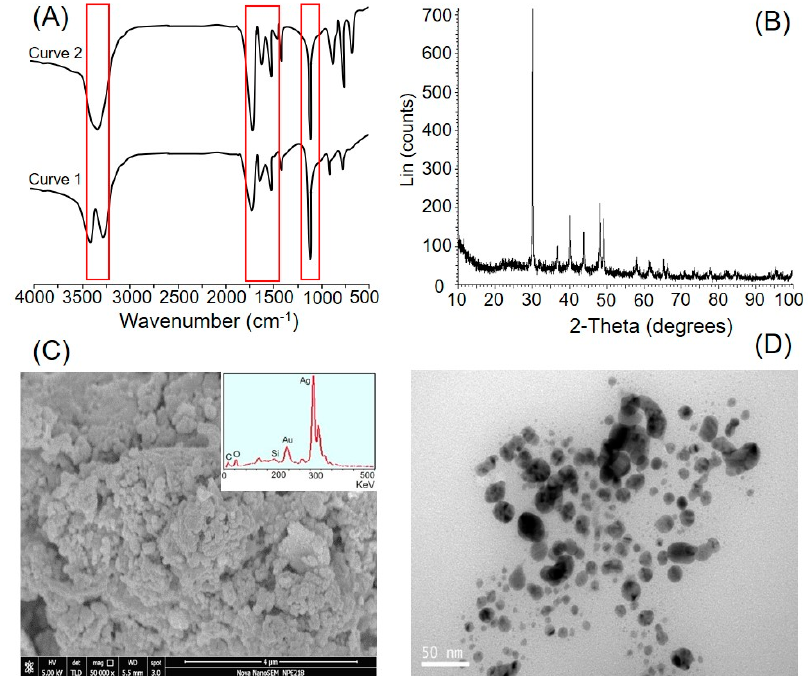
Figure 2. Characterization of Convolvulus arvensis AgNPs: ( A ) Fourier transform infrared spectroscopy (FT-IR) spectrum, ( B ) X-ray diffraction (XRD) spectrum, ( C ) scanning electron microscopy (SEM), and ( D ) transmission electron microscopy (TEM).